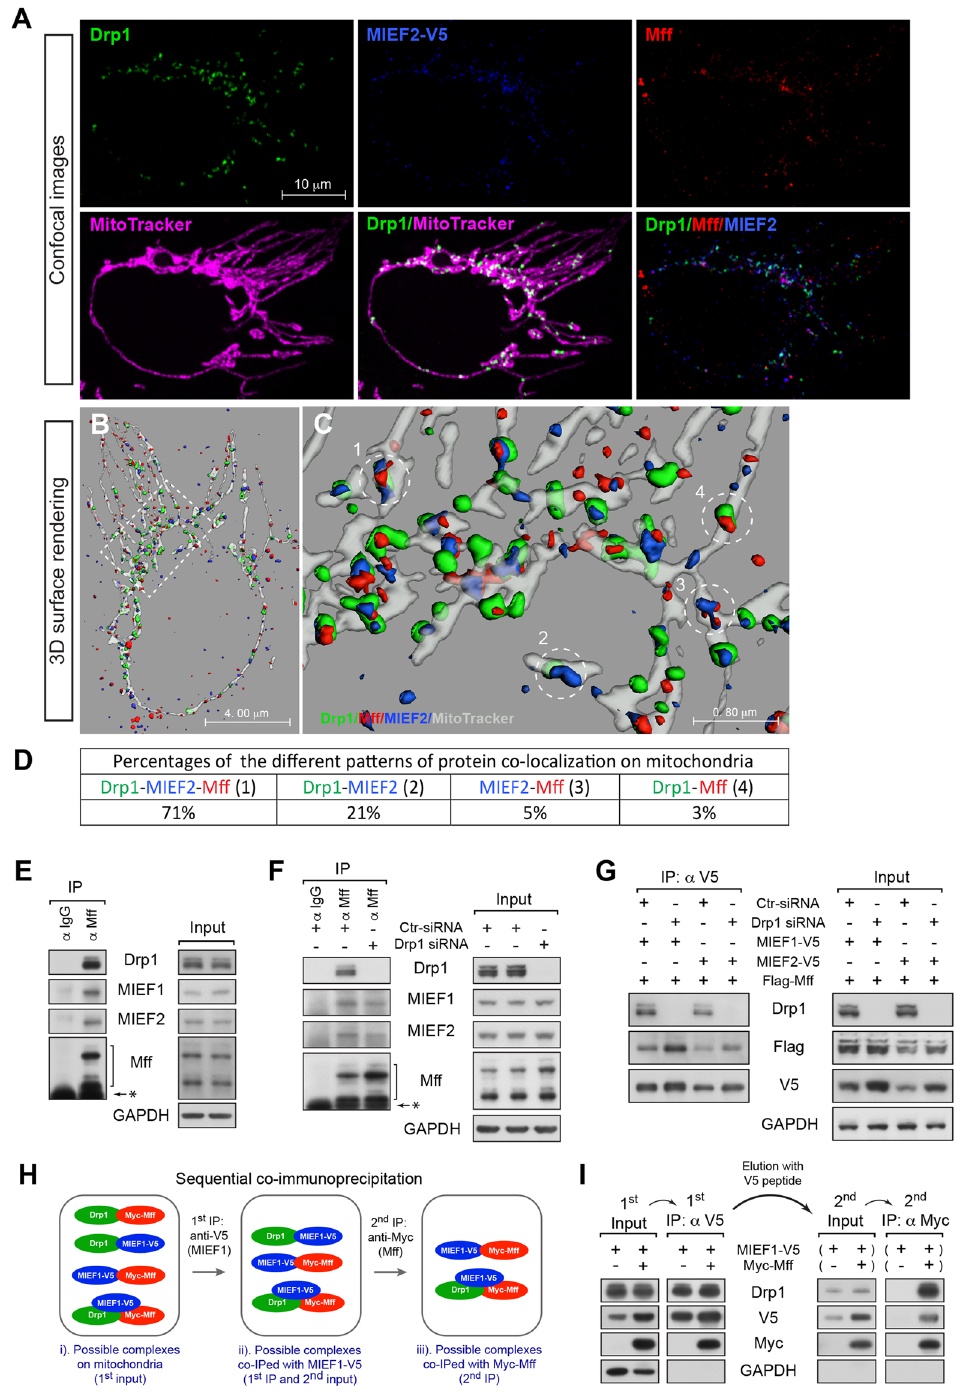
Figure 5. MIEF and Mff interact and form a trimeric complex with Drp1 on the mitochondrial surface. ( A ) Confocal images of 293T cells with stable expression of MIEF2-V5, stained with MitoTracker (red), followed by immunofluorescence staining with anti-V5 for MIEF2 (blue), anti-Drp1 (green) and anti-Mff (red) antibodies. ( B ) Surface rendered three-dimensional reconstructions of the cell as shown in ( A ). The MIEF2 (blue), Drp1 (green) and Mff (red) proteins, as well as mitochondria (gray) are indicated. ( C ) A high magnification view of the boxed area in ( B ) shows the different patterns of protein co-localization on mitochondria, including were obtained from 3D surface rendering images of mitochondria in two cells. ( E ) Mff interacts with MIEF1, MIEF2 and Drp1 at endogenous levels. Lysates from 293T cells were used for co-IP with either goat normal IgG or goat anti-Mff antibody followed by immunoblotting with indicated antibodies. * Represents protein G. ( F ) Knockdown of Drp1 does not affect the endogenous MIEF-Mff association. 293T cells were treated with